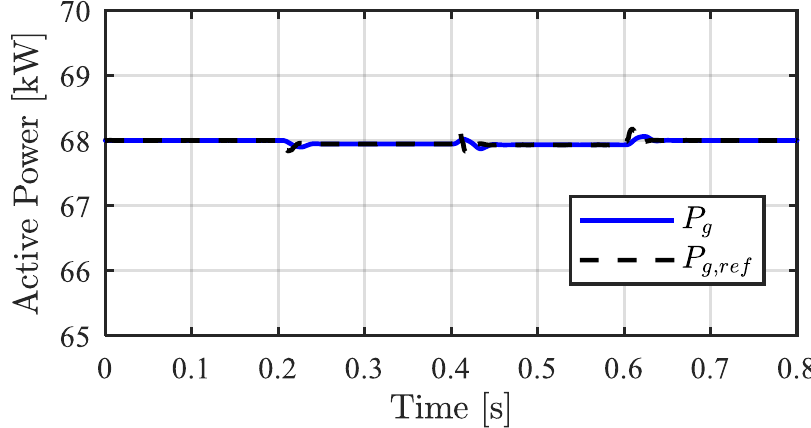
Figure 13. Active power to the grid time profile.